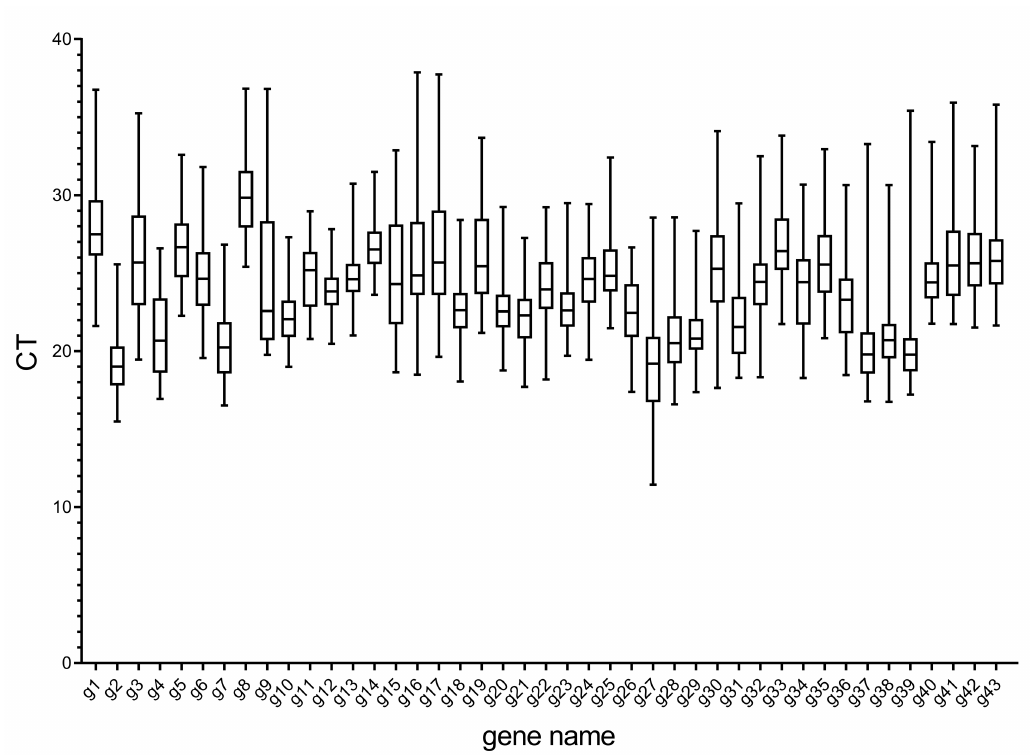
Figure 2. RT-qPCR CT values for the candidate reference genes. Expression data displayed as CT values for each candidate reference gene in all N cadamba samples. The line across the box is depicted as the median. The box indicates the 25th and 75th percentiles. Whiskers represent the maximum and minimum values. Table 2. Summary of the most and least stable internal reference genes with di ff erent